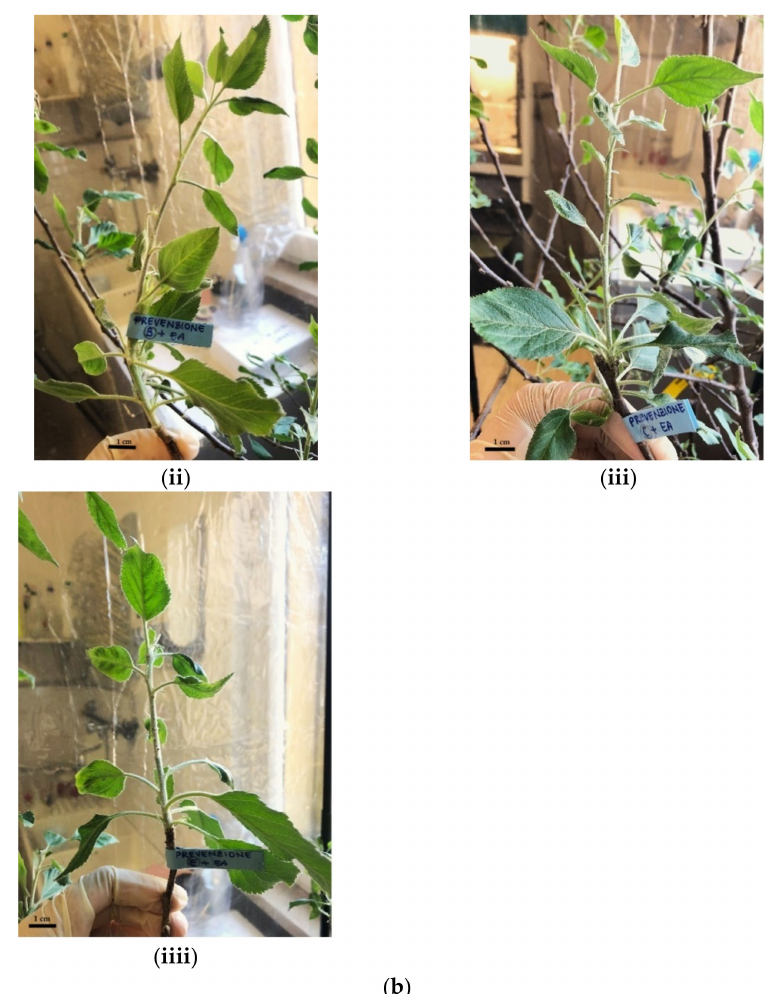
Figure 6. ( a ) Therapeutic approach: Effects of MOEs in infected apple shoots and treated with nebulized extracts after 48 h and 7 days post infection: ( i ) control. Therapeutic TREATMENTS: ( ii ) HA-MOE, ( iii ) HAMD-MOE, ( iiii ) MeOH-MOE. ( b ) Preventive approach: Effects of MOEs in healthy apple shoots nebulized with the extracts and then infected with EA after 24 h post treatments.